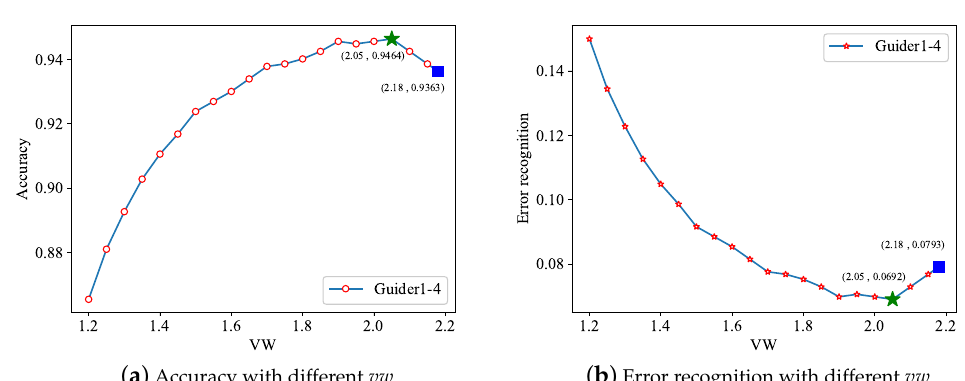
Figure 8. Template matching with different vw